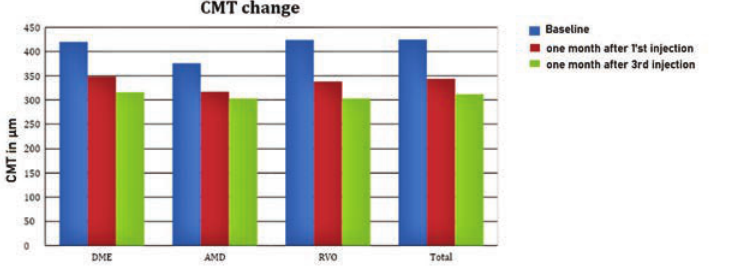
Figure 2. Central macular thickness (CMT) changes. Mean CMT ± SE (μm) at baseline and one month after the first and third Stivant® injection in the DME, AMD, RVO, and in all patients.